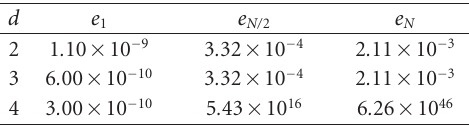
Table 6.11. Approximate error for Example 6.2.